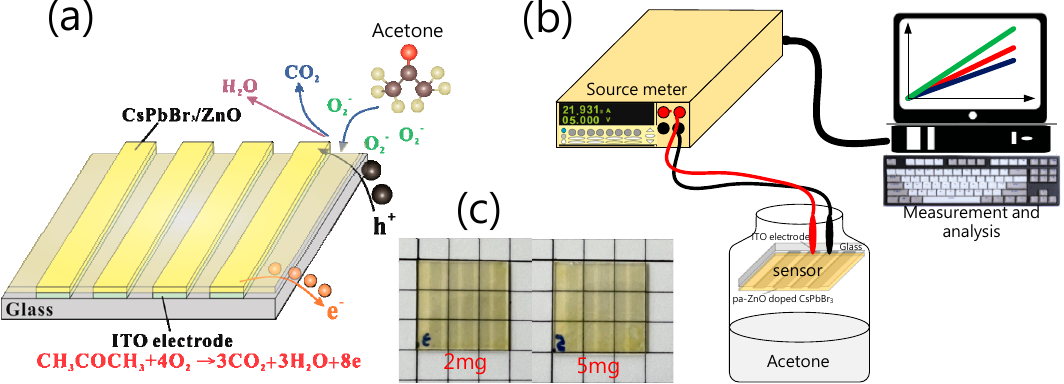
Figure 1. ( a ) Electro-resistance-type pa-ZnO-doped CsPbBr 3 perovskite acetone sensor and sensing mechanism. ( b ) Structure of experiment system. ( c ) The photos of 2- and 5-mg pa-ZnO-doped CsPbBr 3 perovskite films on ITO glass.